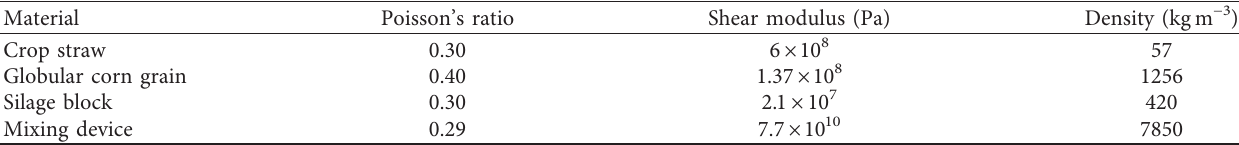
Table 1: Material mechanical properties.